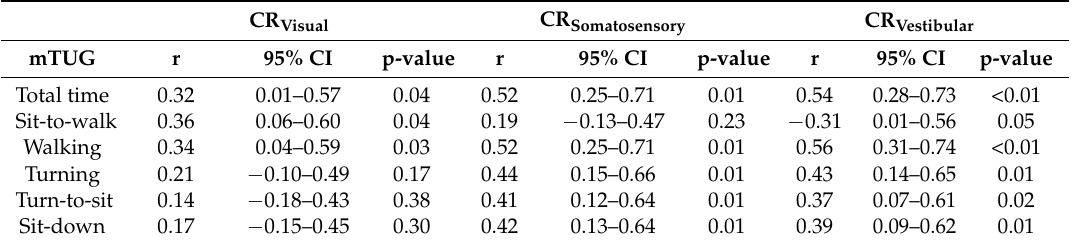
Table 5. Correlation of mTUG total time and mTUG subphases with CR, r = pearson correlation; CI: confidence